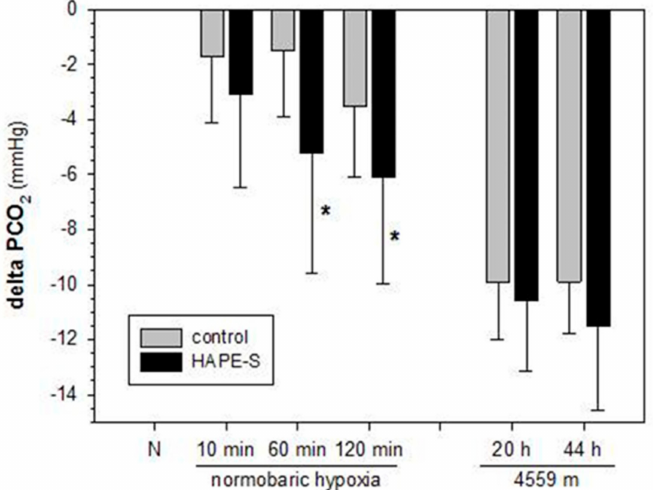
Figure 1. Time-course of decrease in partial pressure of carbon dioxide (PCO 2 ) in controls and high-altitude pulmonary edema –susceptibles (HAPE-S) in hypoxia. The decrease in PCO 2 was calculated as the di ff erence between normoxia and the time-points in hypoxia for the respective studies. Data for normobaric hypoxia (equivalent to 4550 m) are so far unpublished end-tidal PCO 2 values from 15 controls and 17 HAPE-S from a study on the time course of change in systolic pulmonary arterial pressure reported in acute hypoxia reported in [17]). Data on high-altitude at the Capanna Margherita (4559 m) represent the arterial PCO 2 on day 2 of the sojourn from 10 controls and 9 HAPE-S from a study reported in [2]. Mean values ± standard deviation. N normoxia; * indicate significant di ff erence between controls and